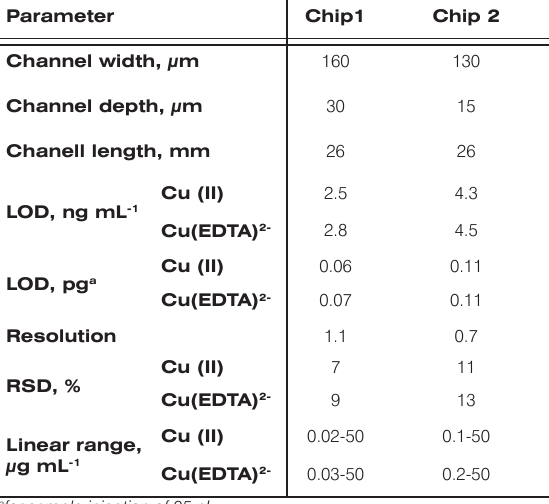
Table 4. Microchips comparison for use in μCE-MIP-OES